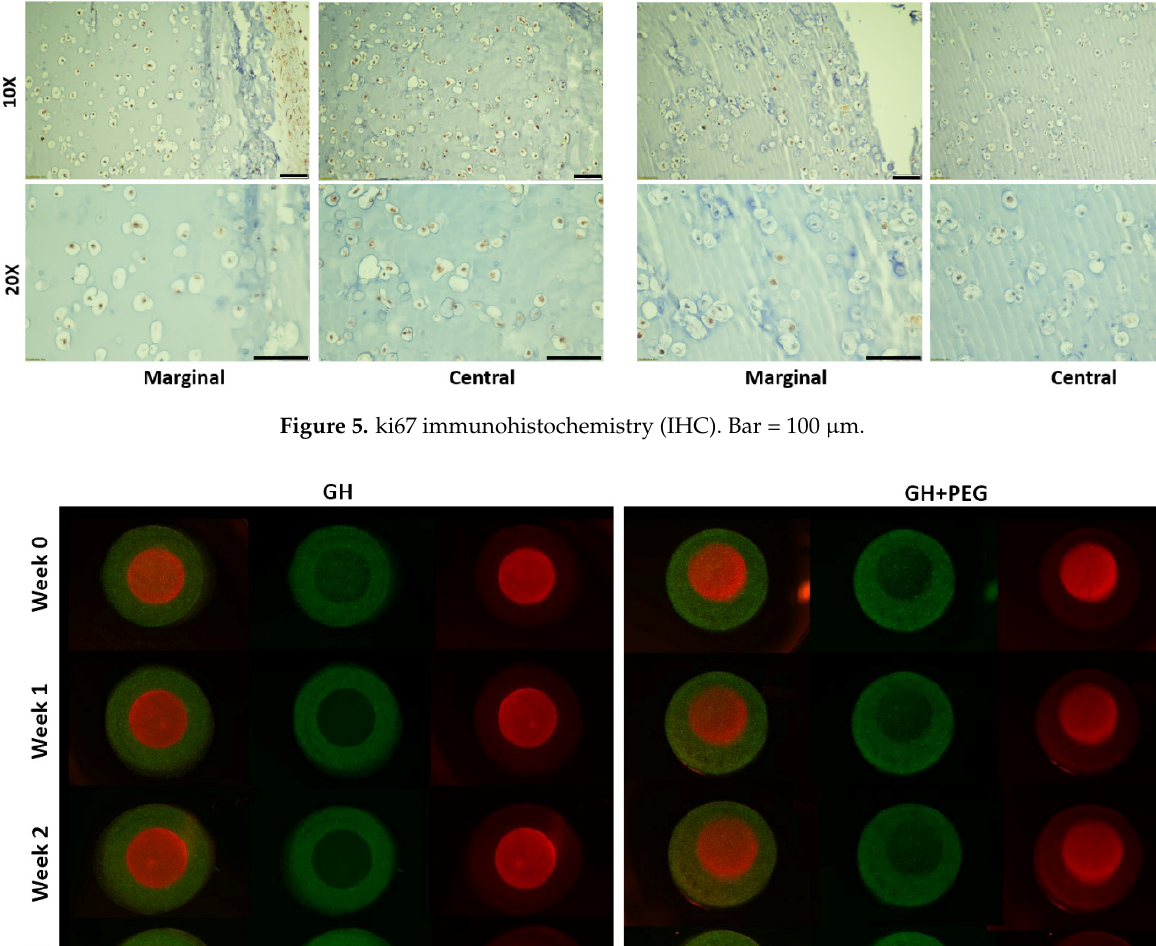
Figure 5. ki67 immunohistochemistry (IHC). Bar = 100 μ m.